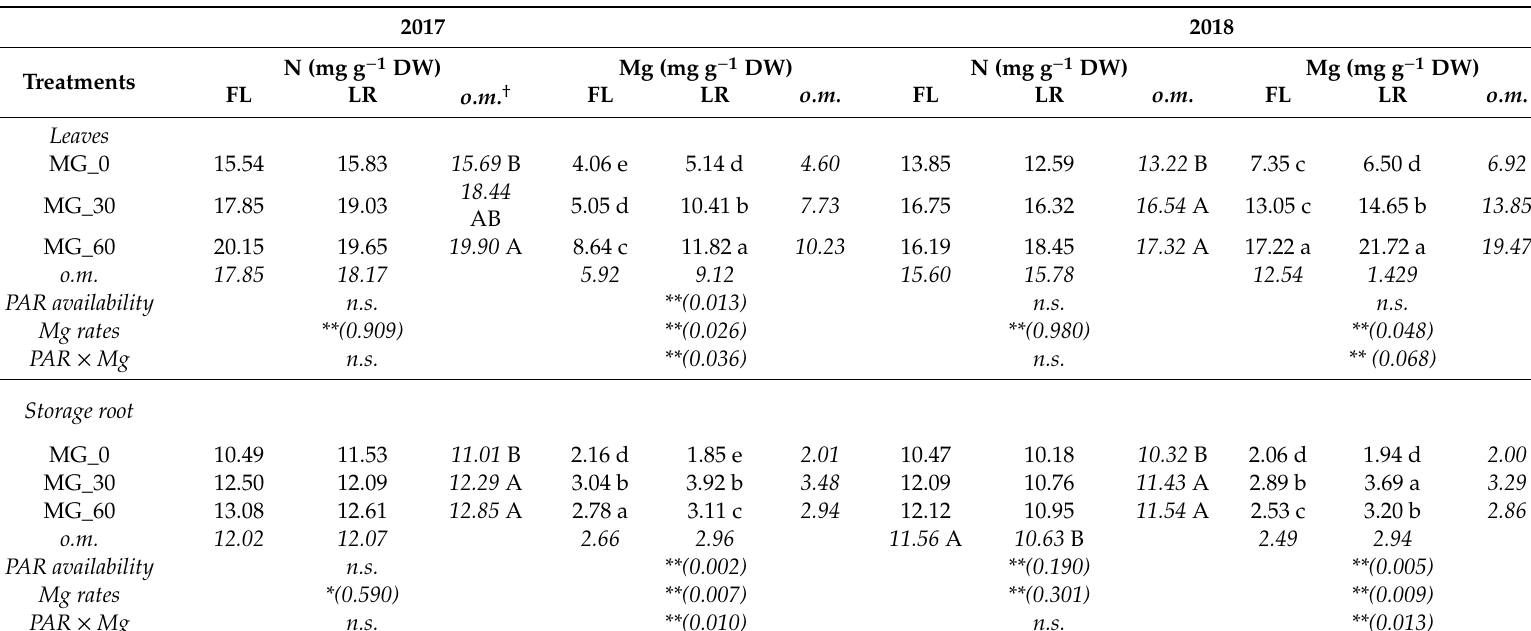
Table 2. N concentration (mg g − 1 DW) and Mg concentration (mg g − 1 DW) in leaves and storage roots of red beet plants subjected to two levels of